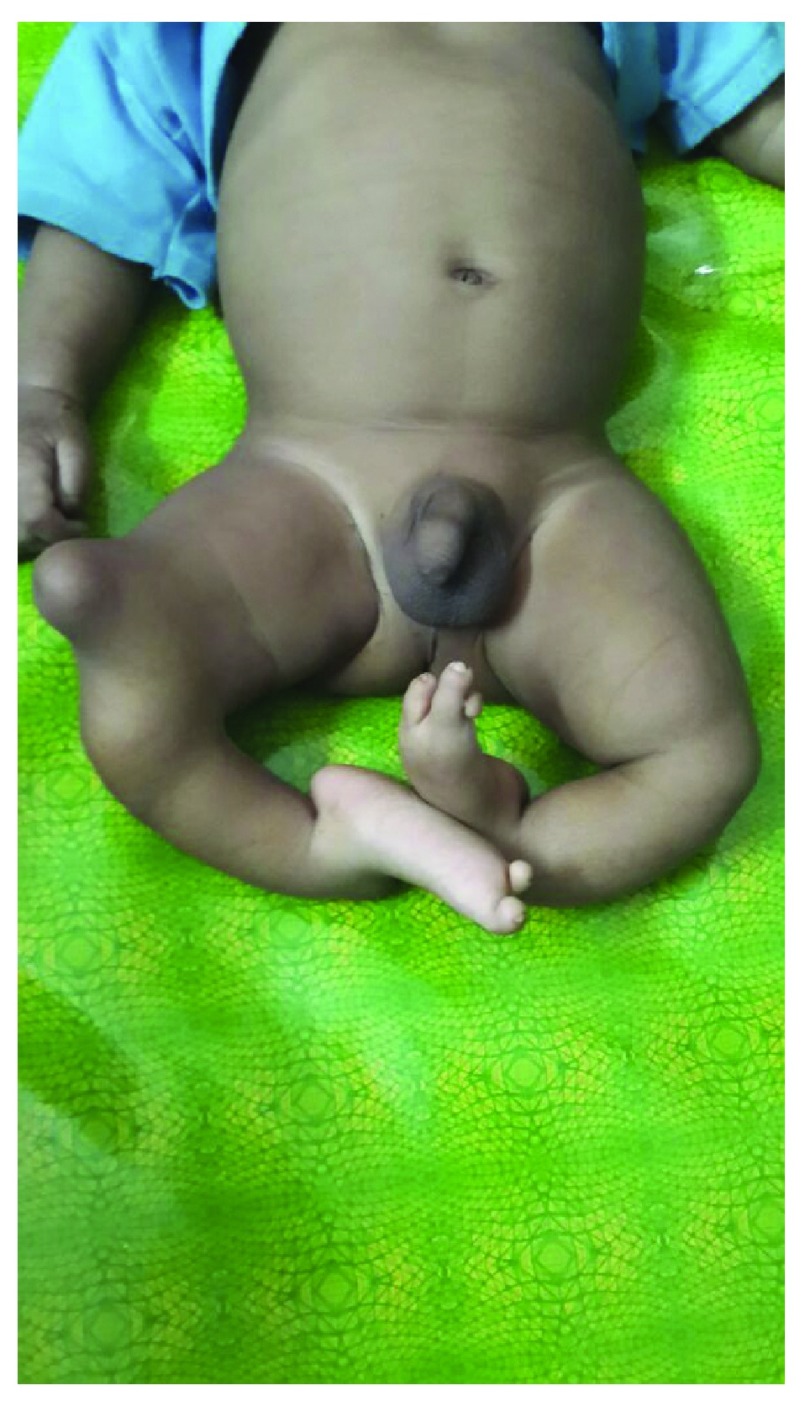
Limb deformities.